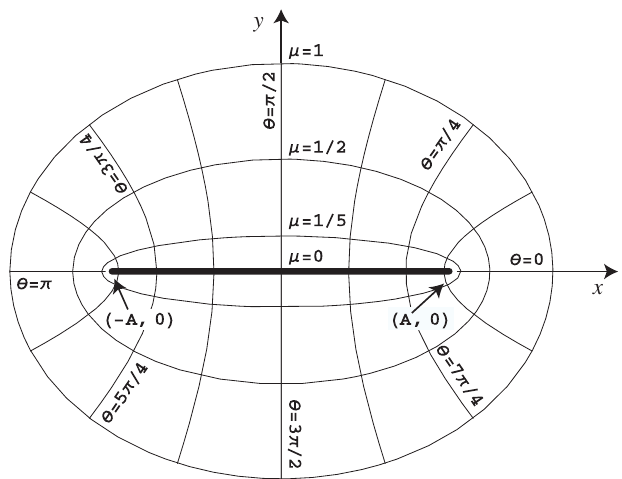
FIG. 11. Elliptic cylindrical